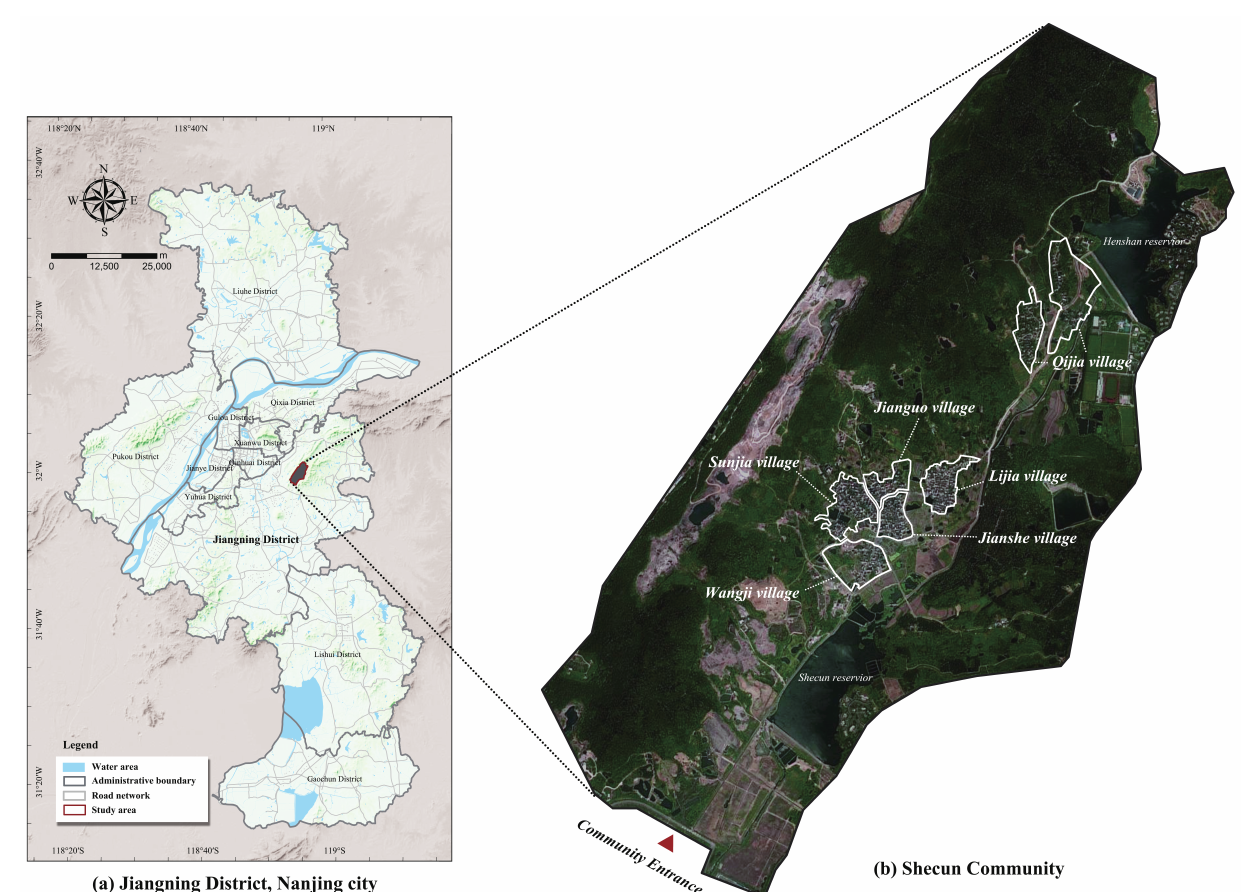
Figure 1. Location map of Shecun Community, Jiangning District, Nanjing, Jiangsu Province ( a ). Geographic Location of the Study Area ( b ) Shecun Figure 1. .